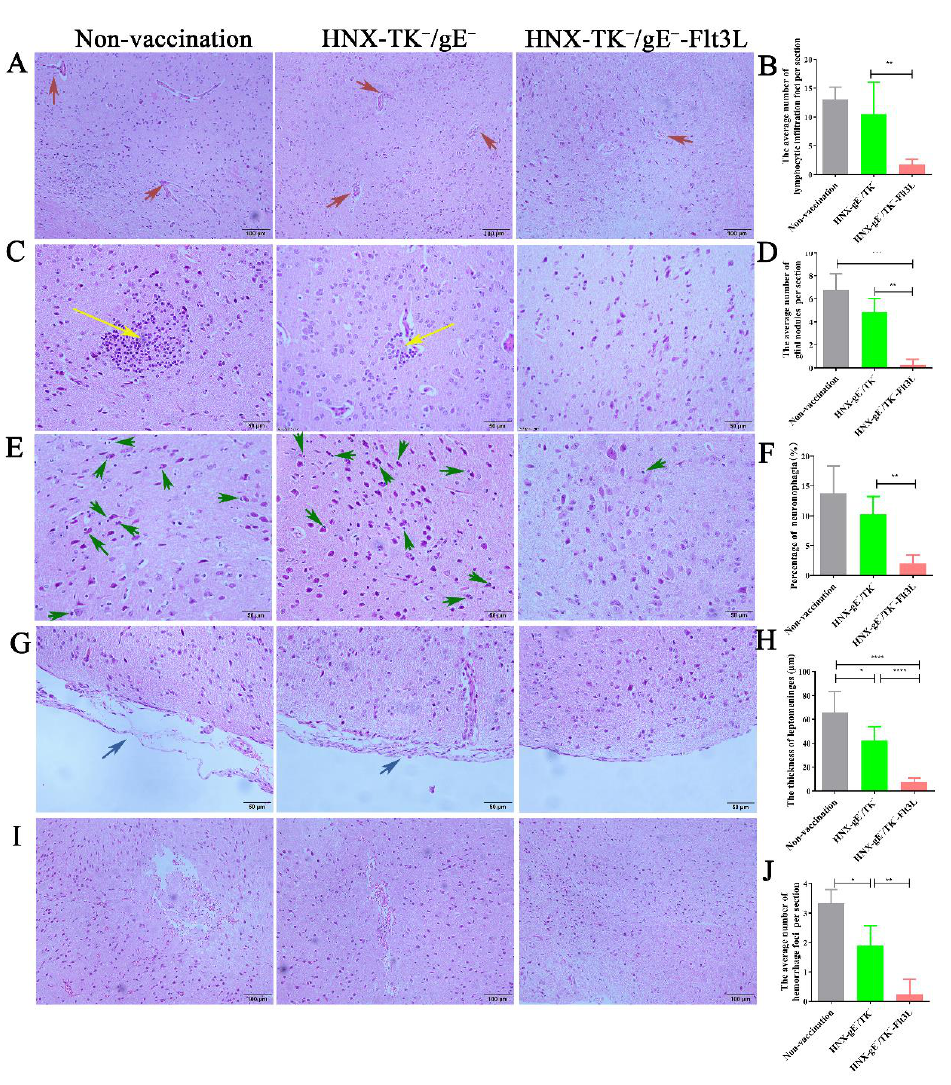
Figure 8. Pathological lesion of HNX-TK − /gE − -Flt3L and HNX-TK − /gE − vaccinated mice. ( A ) Lymphocytic infiltration of mononuclear and lymphocytes cells near blood vessels (red arrow). ( B ) Quantification of lymphocytic infiltration foci. ( C ) Glial nodules and neurons (yellow arrow). ( D ) Quantification of glial nodules. ( E ) Neuronophagia (green arrow). ( F ) Quantification of neuronophagia. ( G ) Leptomeninges expansion (blue arrow). ( H ) Quantification of the thickness of leptomeninges. ( I ) Hemorrhage. ( J ) Quantification of hemorrhage foci. *, p < 0.05; **, p < 0.01 and **** < 0.001.